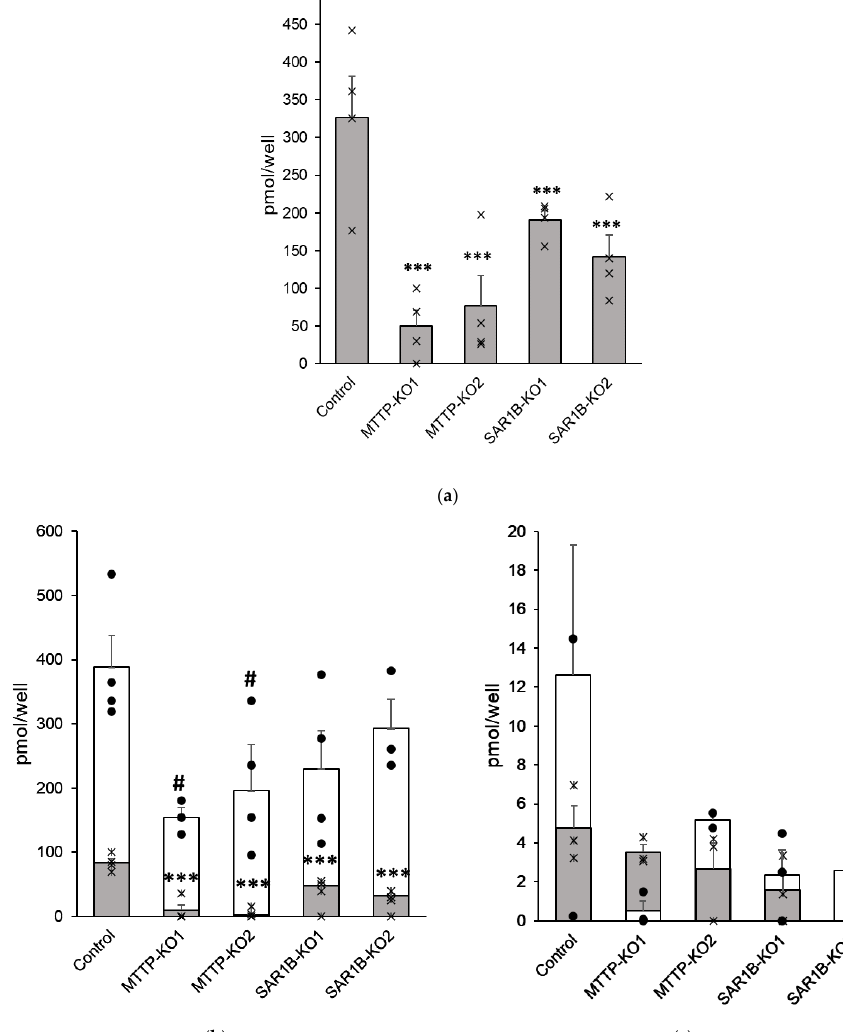
Figure 9. Vitamin E and its basolateral-derivative content after ( a ) free α -tocopherol, ( b ) TAC or ( c ) TPGS acute micellar delivery. Cells were cultured on inserts for 21 days and were incubated with mixed micelles containing α -tocopherol or TAC or TPGS for 6 h. Alpha-tocopherol and its derivative levels were measured by HPLC after liquid – liquid extraction with hexane. Data are expressed as means ± SEM ( n = 4). For ( b , c ), grey bars with crosses represent free α -tocopherol and white bars with dots represent TAC ( b ) or TPGS ( c ). For all figures, asterisks indicate a statistically significant difference in TAC concentrations between control and KO clones (*** p < 0.0001) and a hash (#) indicates a statistically significant difference in TAC or TPGS concentrations between control and KO clones (# p <